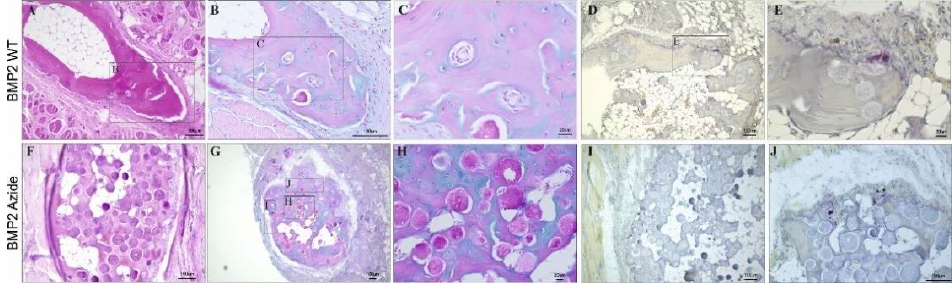
Figure 6. Histological evaluation of ectopic bone formation in BMP2 WT and BMP2 Azide RCP-based implants. Representative images of various staining techniques analyzing ectopic bone formation after 12 weeks of subcutaneous implantation in ( A – E ) BMP2 WT-induced ossicles and ( F – J ) BMP2 Azide-induced ossicles. Staining techniques: H&E ( A , F ), Alcian Blue, ( B , C , G , H ) tartrate-resistant acid phosphatase (TRAP) ( D , E , I , J ). Scale bar represents 100 µm ( A , B , D , F , G , I , J ), 20 µm ( C , E , H ).